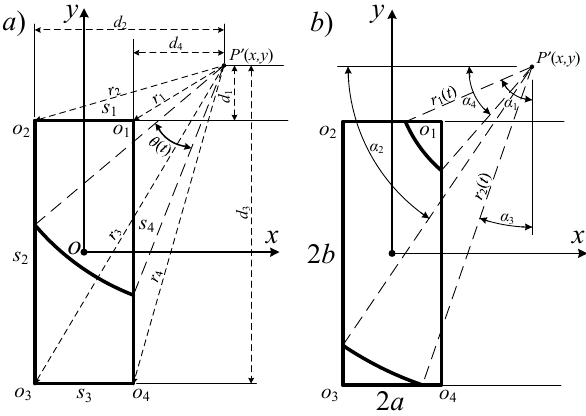
Figure 2. Illustration of the relevant symbols: ( a ) distance d i and r i ; and ( b ) angles α i ( i = 1–4).